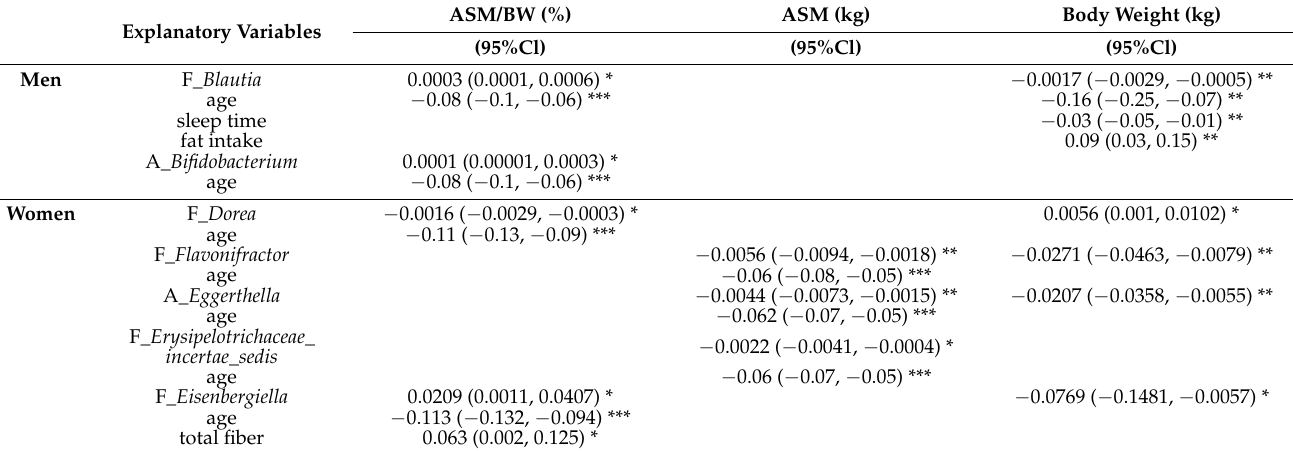
Table 4. Association between gut microbiota and body